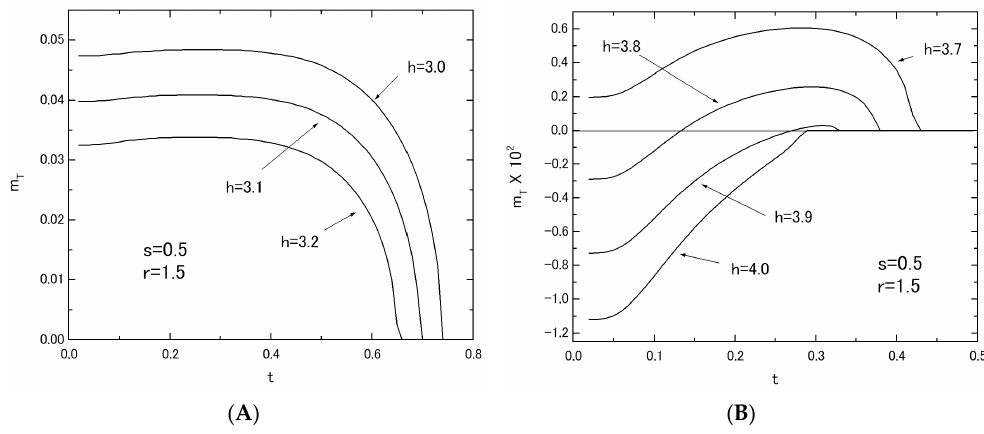
Figure 11. The temperature dependences of m T in the system B with s = 0.5 and r = 1.5; the value of h is changed from h = 3.0 to h = 3.2 ( A ) and from h = 3.7 to h = 4.0 ( B